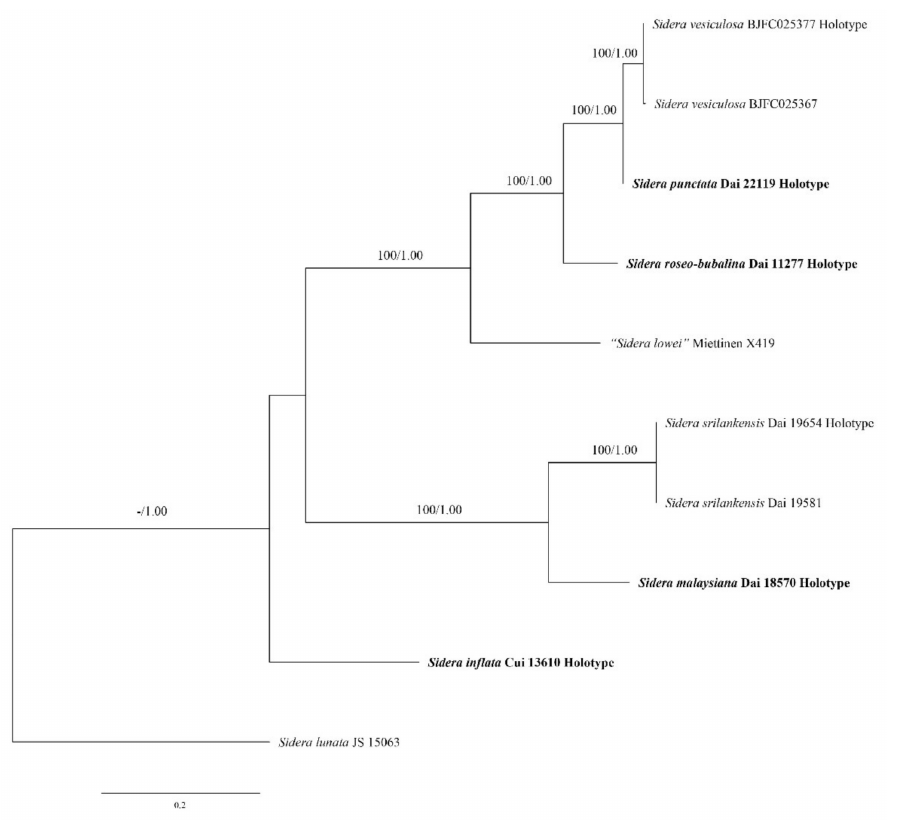
Figure 2. Phylogeny of Sidera new species and related species generated by ML analyses based on ITS sequences. Branches are labeled with maximum likelihood bootstrap >50% and Bayesian posterior probabilities >0.90, respectively. New species are indicated in